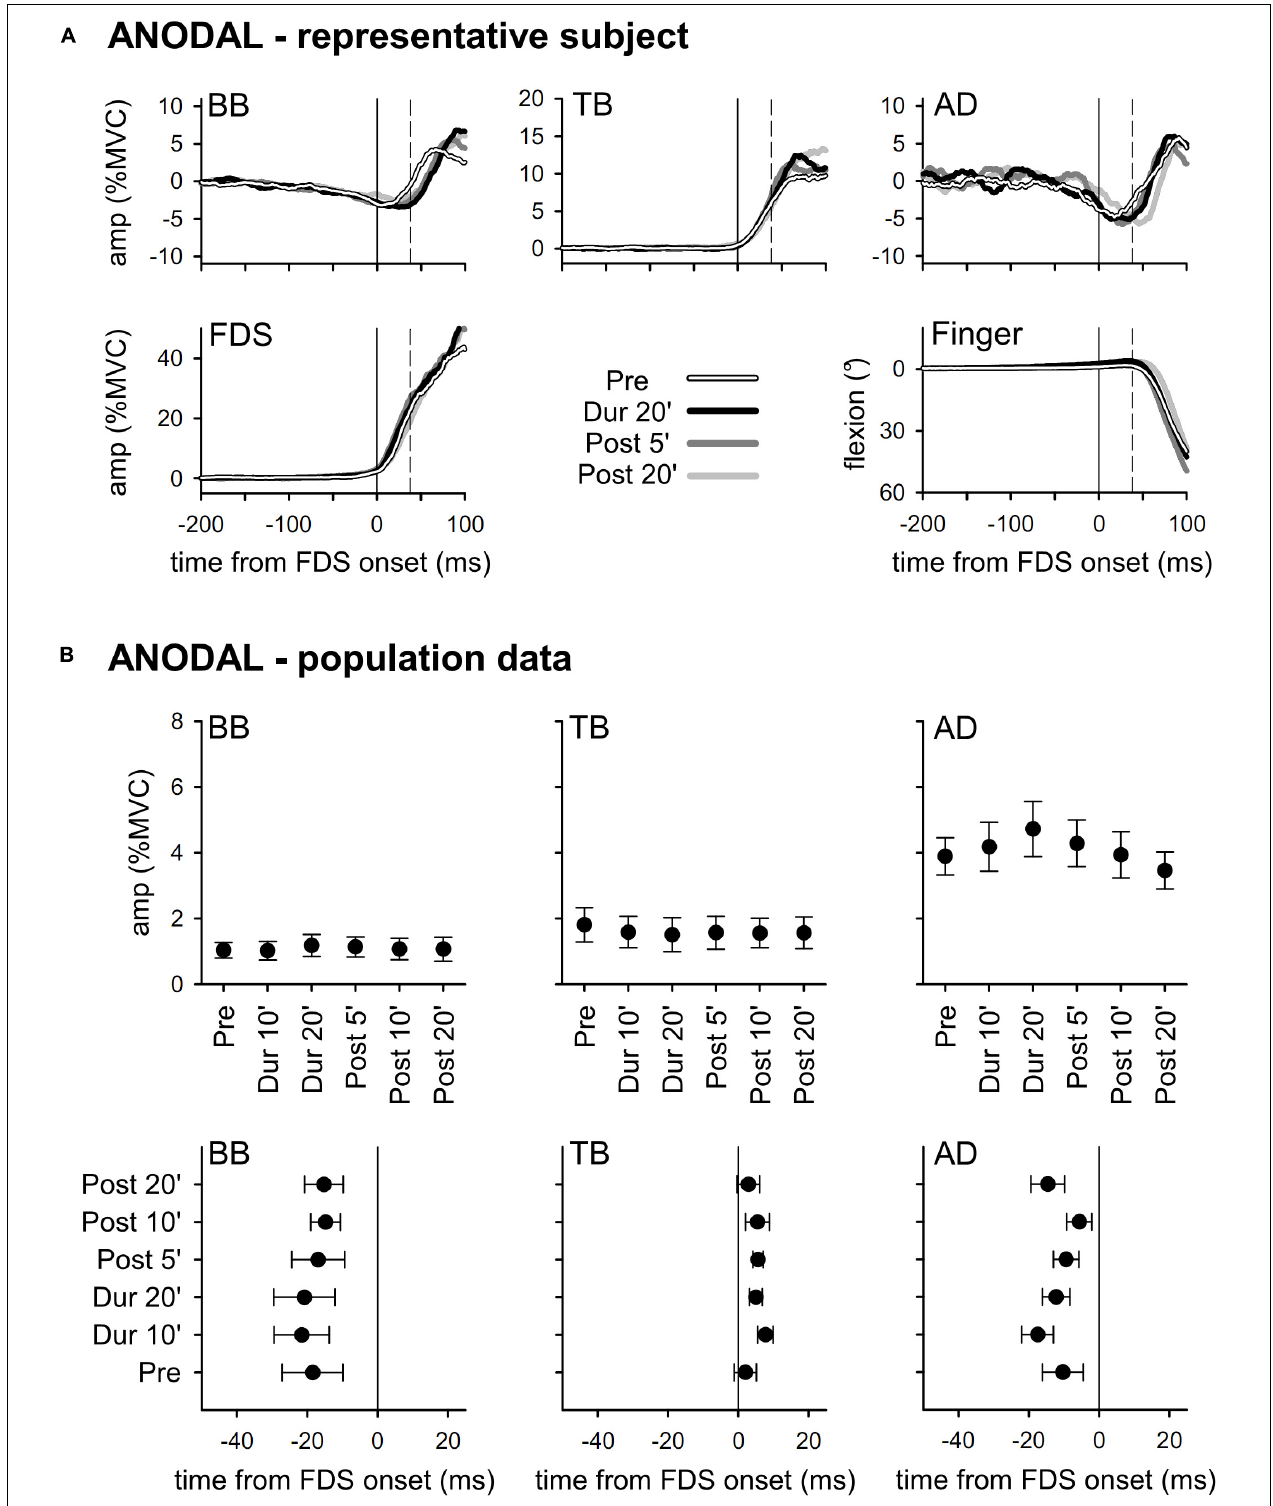
FIGURE 3 | Traces from a representative subject (A) , as well as mean ( ± SE) amplitude and latencies of APAs recorded in the BB, TB, and AD muscles of all subjects (B) who underwent ANODAL tDCS. Same layout as in Figure 2 . It is apparent that tDCS had no effect on APAs, as no significant changes occurred among the different time-points ( Pre vs. Dur 10’ vs. ...vs. Post 20’ ).